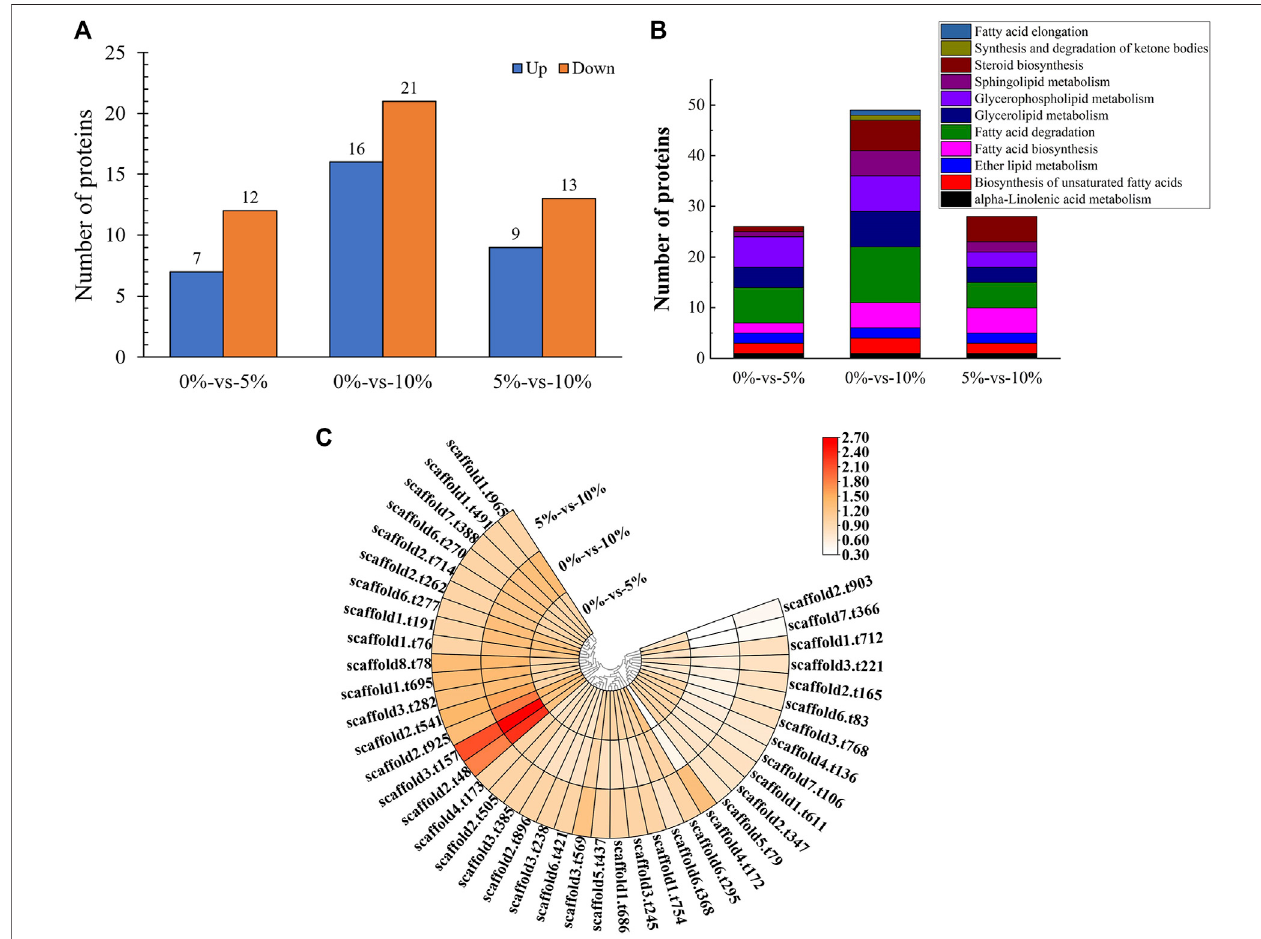
FIGURE 3 | Proteomic analysis of lipid metabolism. (A) Number of differentially expressed proteins under different salt stress; (B) Pathway enrichment of differentially expressed proteins; (C) Differentially expressed proteins under different salt stress.